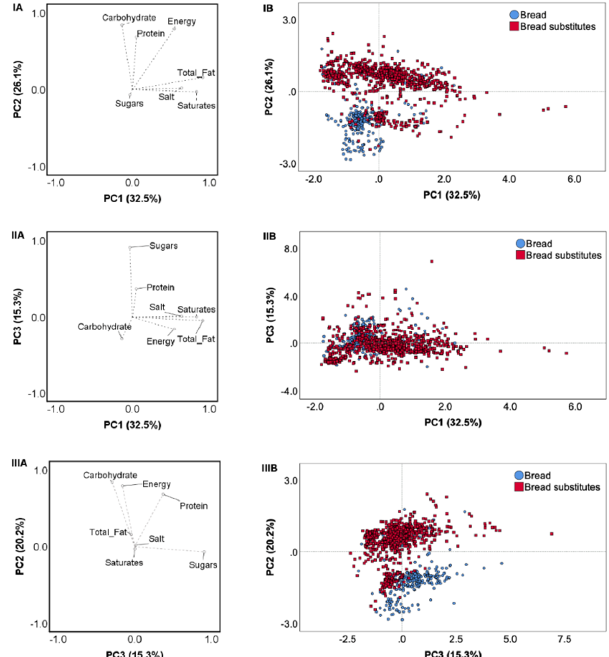
Figure 1. Principal component analysis (PCA) describing the inter-category variability based on the nutritional composition of analyzed products (energy (kcal/100 g), total fat (g/100 g), saturates (g/100), carbohydrate (g/100 g), sugars (g/100 g), protein (g/100 g), and salt (g/100 g)). Loading plots of PC1 versus PC2 (IA), PC1 versus PC3 (IIA) and PC3 versus PC2 (IIIA); score plots of the nutrition composition for bread and bread substitutes of PC1 versus PC2 (IB), PC1 versus PC3 (IIB) and PC3 versus PC2 (IIIB).